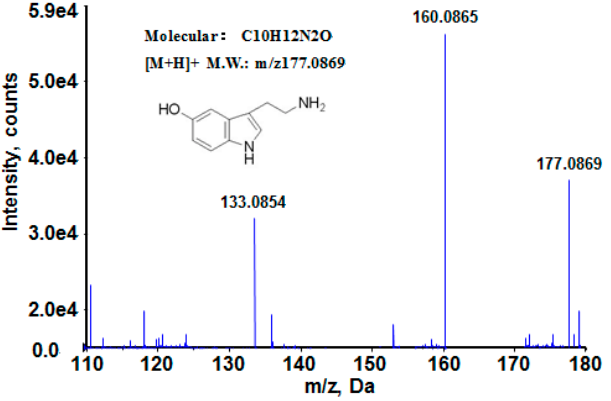
Figure 9. The MS spectrum and product ion spectrum of the metabolite ion at m/z 177.0869 obtained by TOF-MS/MS.